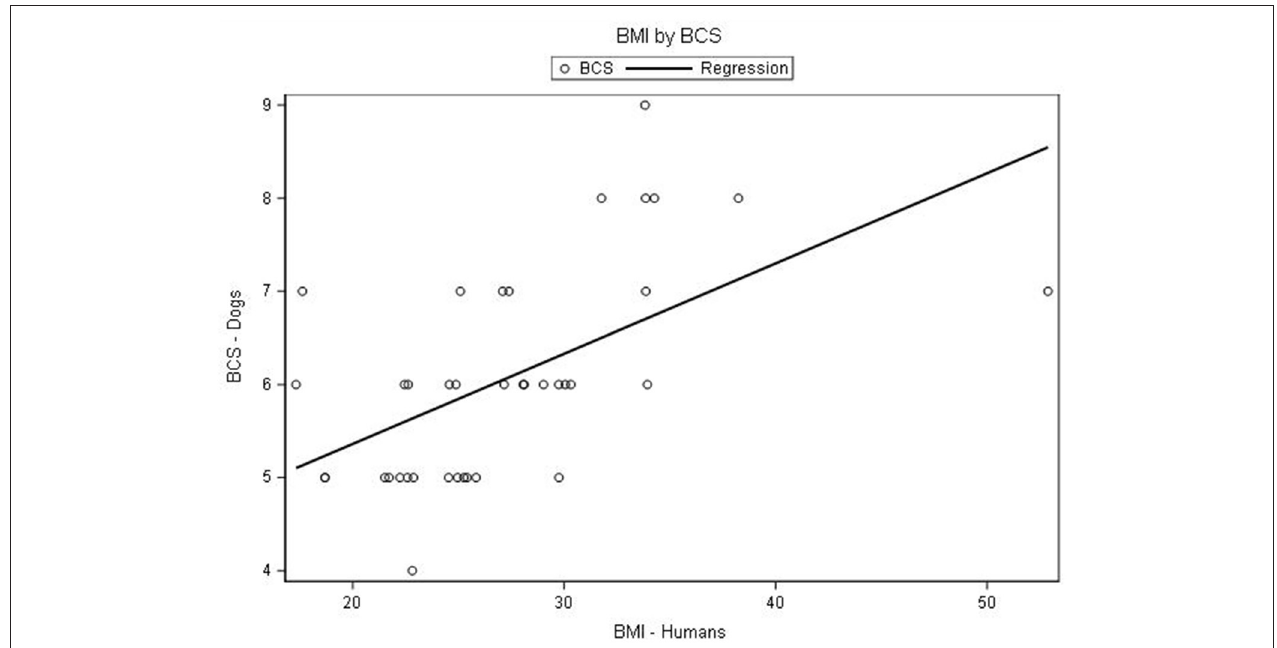
FIGURE 1 | Scatterplot showing distribution of body mass index (BMI) of 38 dog owners and body condition score (BCS) of their dog. *BMI was measured in kg/m 2 and defined as underweight ( < 18.5), healthy range (18.5–24.9), and overweight (25–29.9) and obese ( > 30). † BCS was measured on a scale from 1 (underweight) to 9 (obese) and defined as underweight (1–3), healthy range (4–5), overweight (6–7), and obese